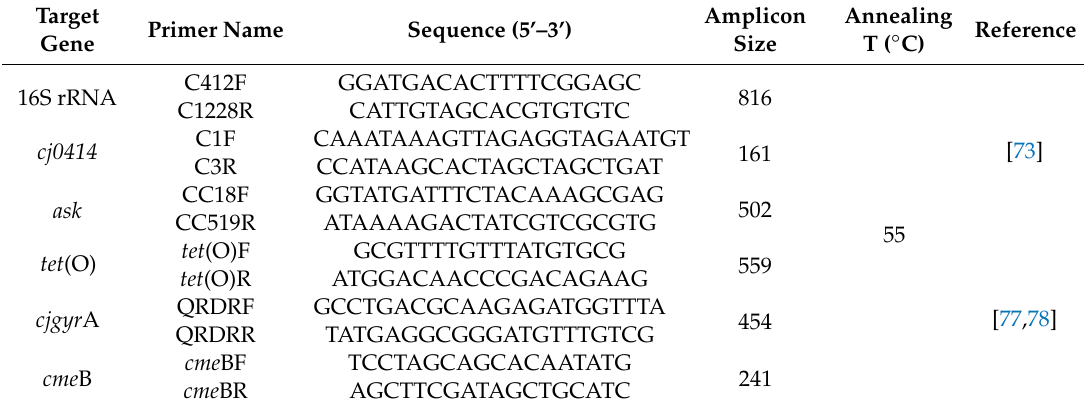
Table 3. Target genes, primer sequences, and amplification